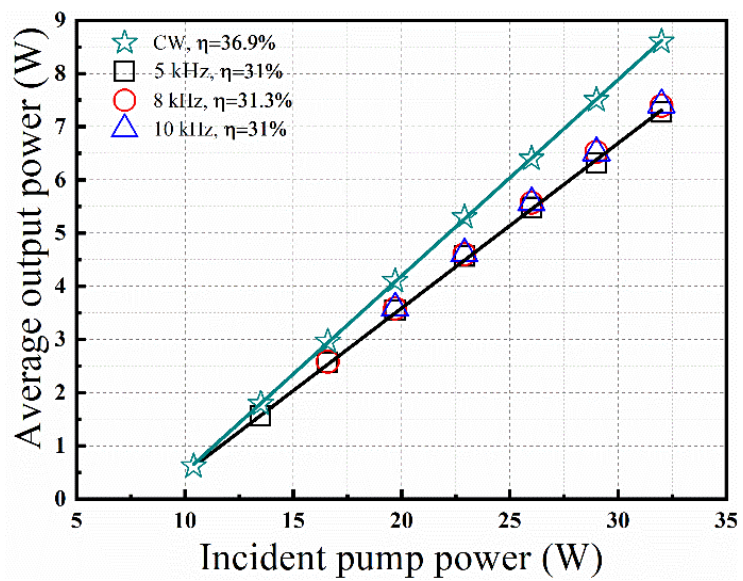
Figure 6. Numerically calculated output power versus the incident pump power for the CW and AO Q-switched Tm:YLF laser.